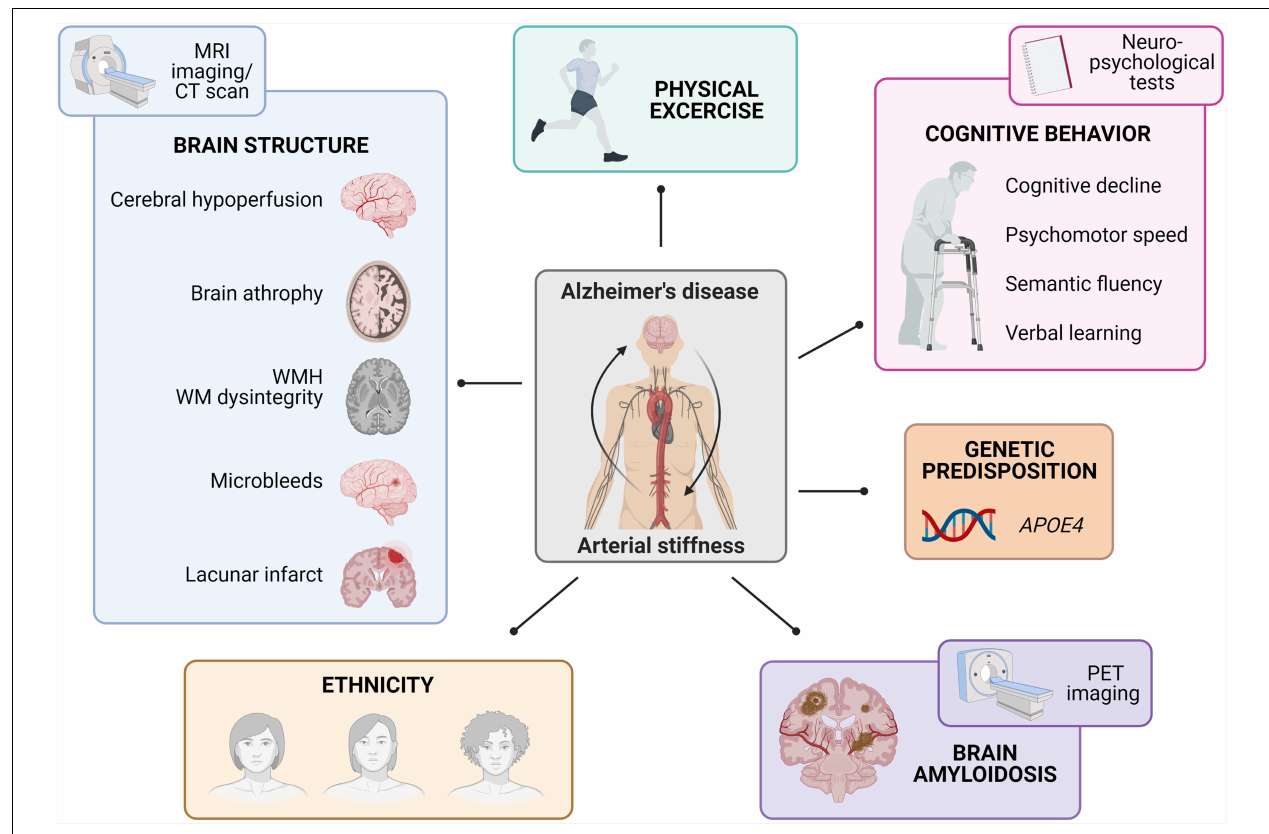
FIGURE 1 | Summary of epidemiological findings linking arterial stiffness to Alzheimer’s disease. The observed links between arterial stiffness and Alzheimer’s disease comprise brain structure changes (as studied via MRI-based imaging techniques), physical fitness, cognitive behavior (as studied with neuropsychological tests), APOE4 genetic predisposition, brain amyloidosis (as studied via A β -PET imaging), and differences in ethnicity (MRI, magnetic resonance imaging; MWH, white-matter-hyperintensities; WM, white matter; PET, positron emission